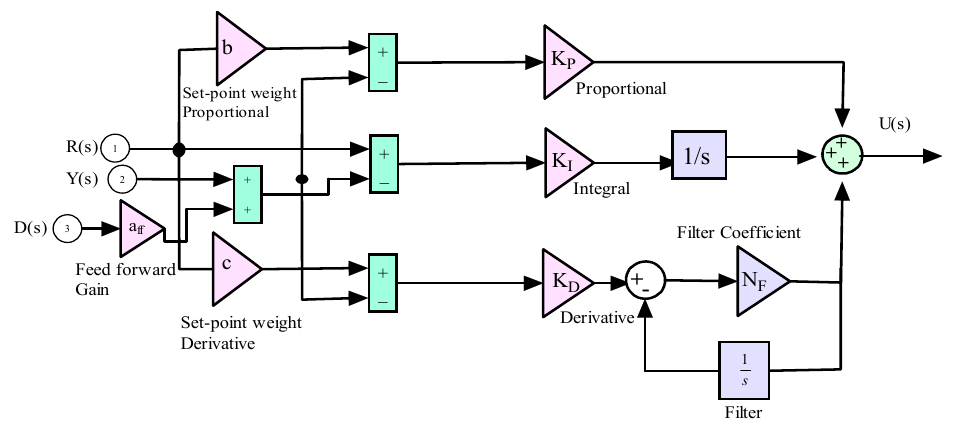
Figure 11. Three-degree-of-freedom PID controller. Table 4. Merits and demerits of controllers